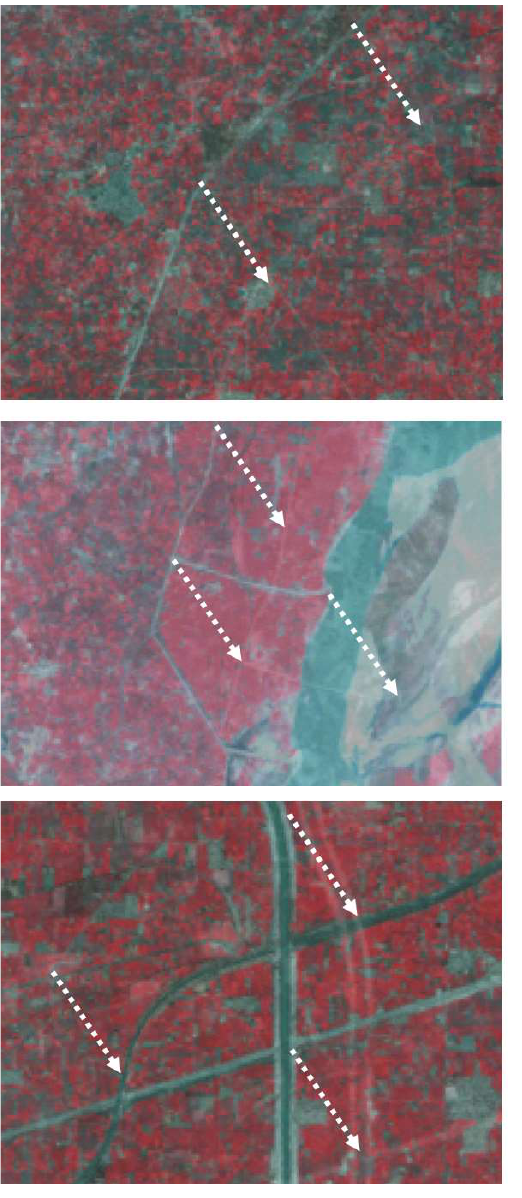
Figure 7. Overlap between unregistered (on the left column) and registered (on the right column) images of the ‘Multan’ dataset as obtained by applying MIRA procedure. Yellow arrows refer to the position of some corresponding features.